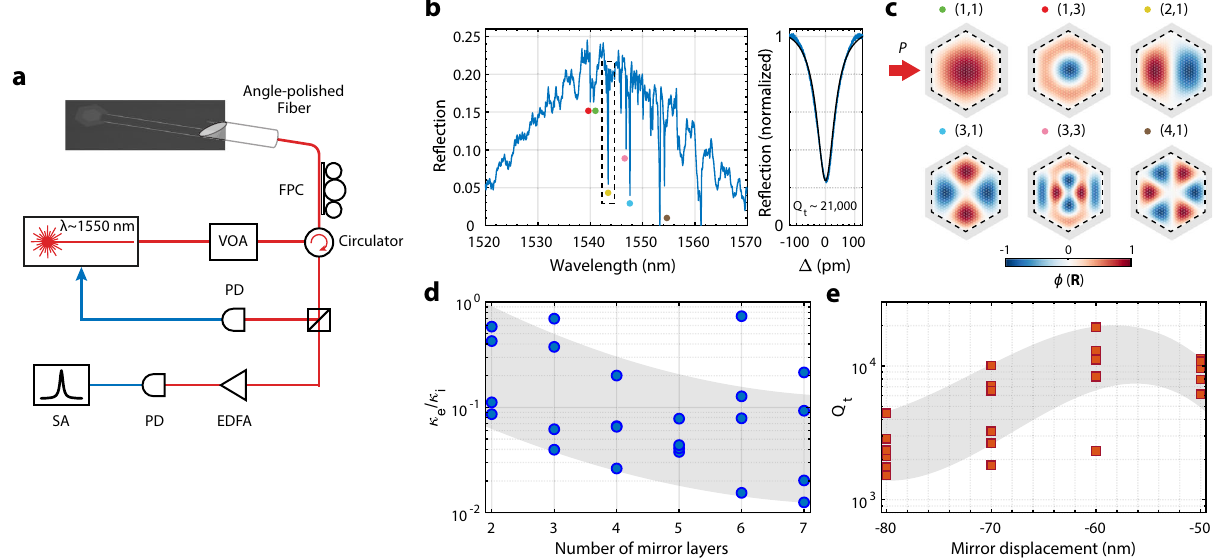
Fig. 3 Multimode optical spectroscopy. a Schematic diagram of the measurement setup. The pump light is guided into the on-chip device using an angle- polished fi ber. The re fl ected light is divided by a directional coupler for optical (10%) and mechanical (90%) spectroscopy. The optical signal is used to lock the laser-cavity detuning. VOA variable optical attenuator, FPC fi ber polarization controller, EDFA erbium-doped fi ber ampli fi er, PD photodetector, SA spectrum analyzer. b Optical spectrum of a device with multiple standing-wave resonances, one of which has a total quality factor of 21,000 (right). c Mode envelope ϕ ( R ) of standing-wave resonances with given orders corresponding to the dotted resonances in b . The arrow indicates the waveguide input. d κ e = κ i for different numbers of nominal mirror layers at the junction between the optomechanical crystal and waveguide. For each number of mirror layers, multiple devices with different photonic crystal mirror displacements are measured. e Total optical quality factor versus the displacement of the photonic crystal mirror, i.e., d ‒ a . e is plotted using the same set of data as d